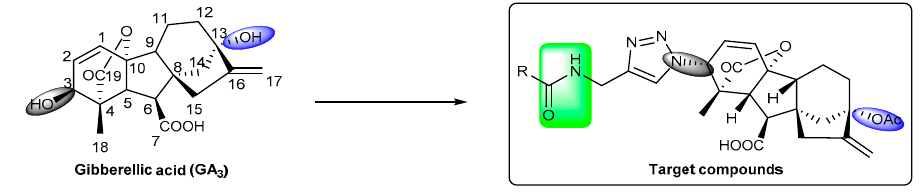
Figure 2. The molecular design of target compounds.